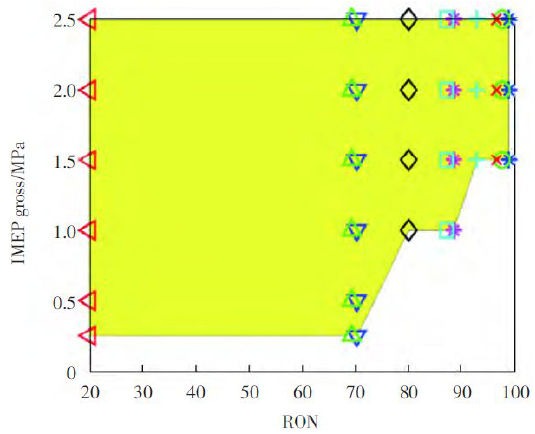
Fig. 4 Variation law of stable operating conditions with octane number